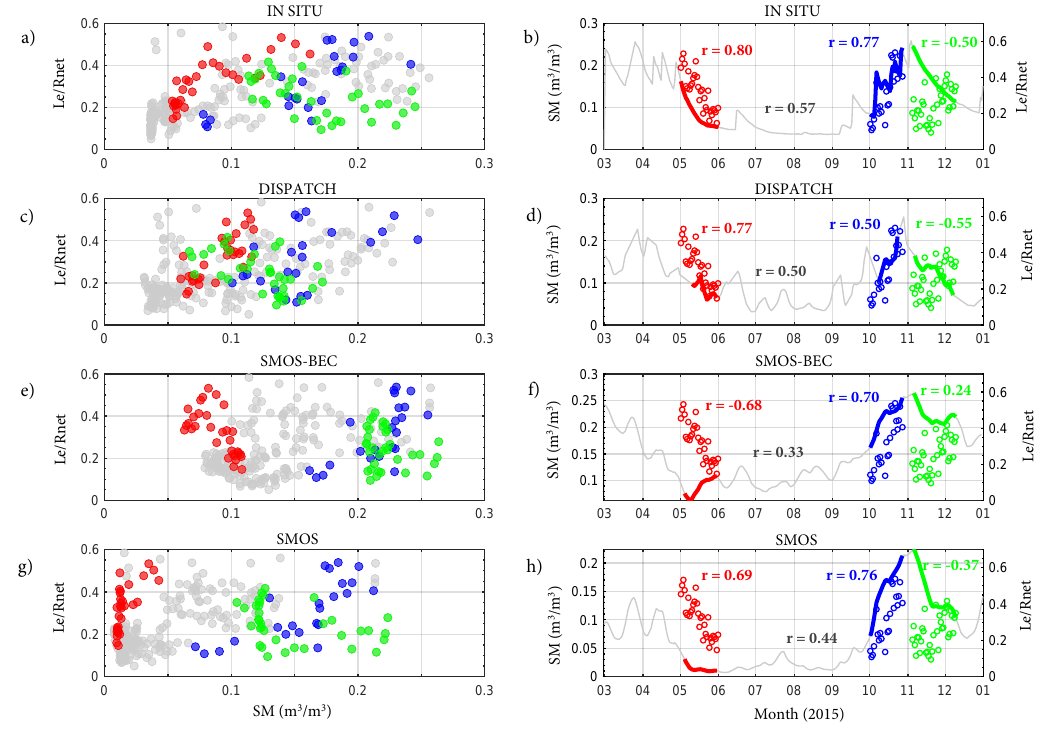
Figure 8. ( a ) Scatter plot of latent heat flux normalised by net radiation (Le/Rnet, y-axis) versus the in situ soil moisture (SM, x-axis) for daily values calculated from 10:00 to 14:00 UTC. Grey points correspond to all the analysed period; red points to the drying period in May; blue points to a wet period in October after the dry season; green points correspond to a drying period with only light rain events after the previous wet weeks. ( b ) In situ SM evolution throughout the year (lines) and Le/Rnet measurements (points), with the same periods than in ( a ) indicated with colours. Correlations between both variables are indicated with text. ( c , d ) Idem but using SM from DISPATCH at the pixel where the site is. ( e , f ) Idem but using SM from SMOS-BEC. ( g , h ) Idem but using SMOS